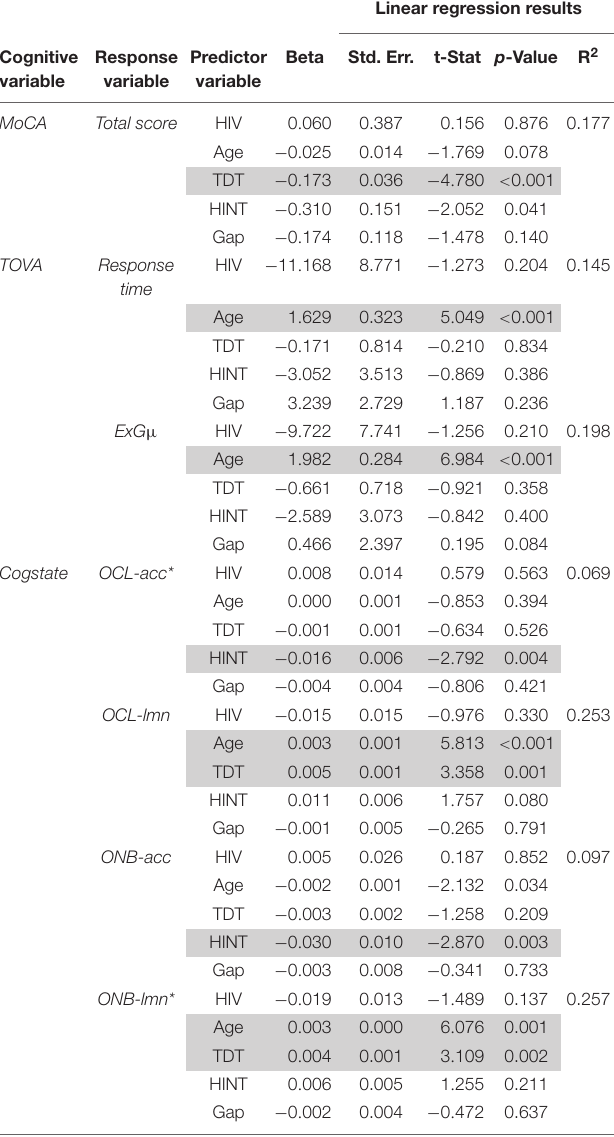
Linear regression